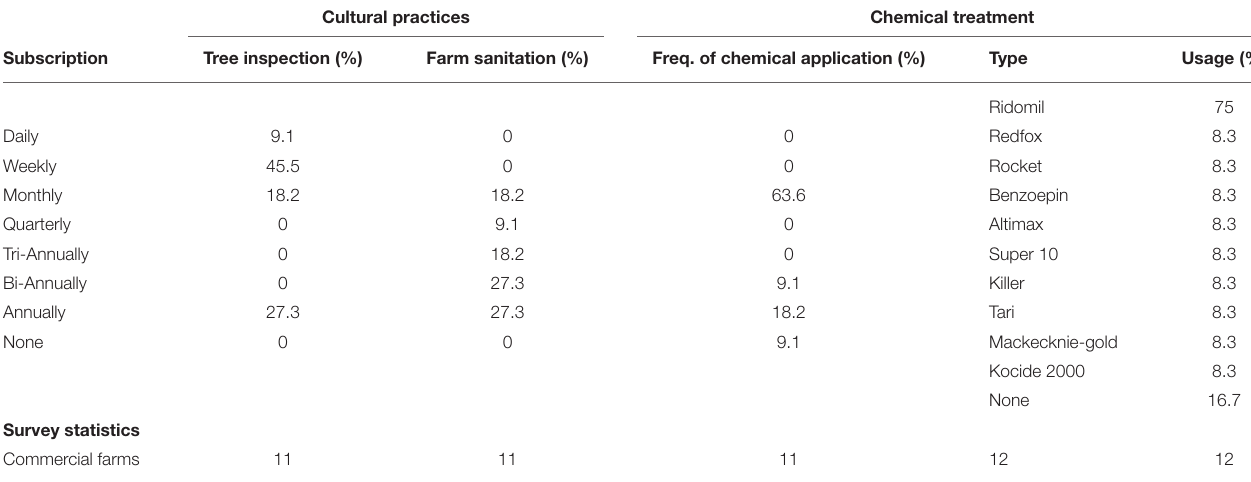
TABLE 5 | Management practices adopted by some cocoa farmers in